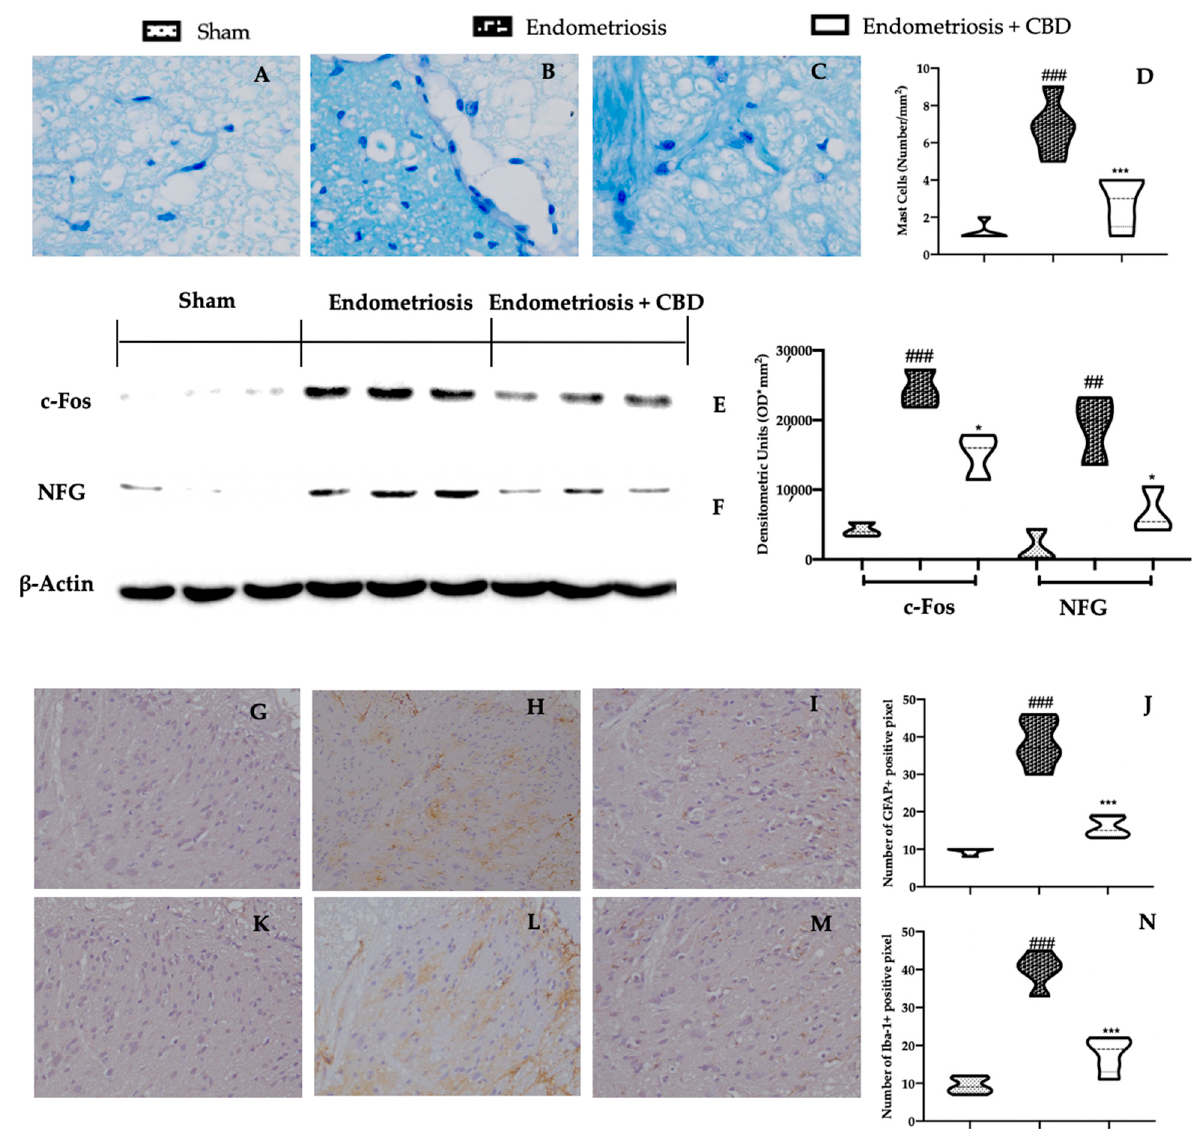
Figure 5. CBD administration reduced pain-mediators and neuroinflammatory state endometriosis- induced: Toluidine blue staining: sham ( A ), vehicle ( B ), CBD ( C ), mast cell number ( D ), Western blot analysis of c-FOS ( E ), and NGF ( F ) expression; Immunohistochemical analysis of GFAP: sham ( G ), vehicle ( H ), CBD ( I ), graphical quantification of GFAP expression ( J ), immunohistochemical analysis of Iba-1: sham ( K ), vehicle ( L ), CBD ( M ), graphical quantification of Iba-1 expression ( N ). For each analysis, n = 5 animals were employed. For the toluidine blue staining and the immunohistochemical analysis, n = 5 different fields from n = 5 different animals were evaluated. * p < 0.05 vs. endometriosis, ## p < 0.01 vs. sham, *** p < 0.001 vs. endometriosis, ### p < 0.001 vs. sham. Scale bar 100 μ m.